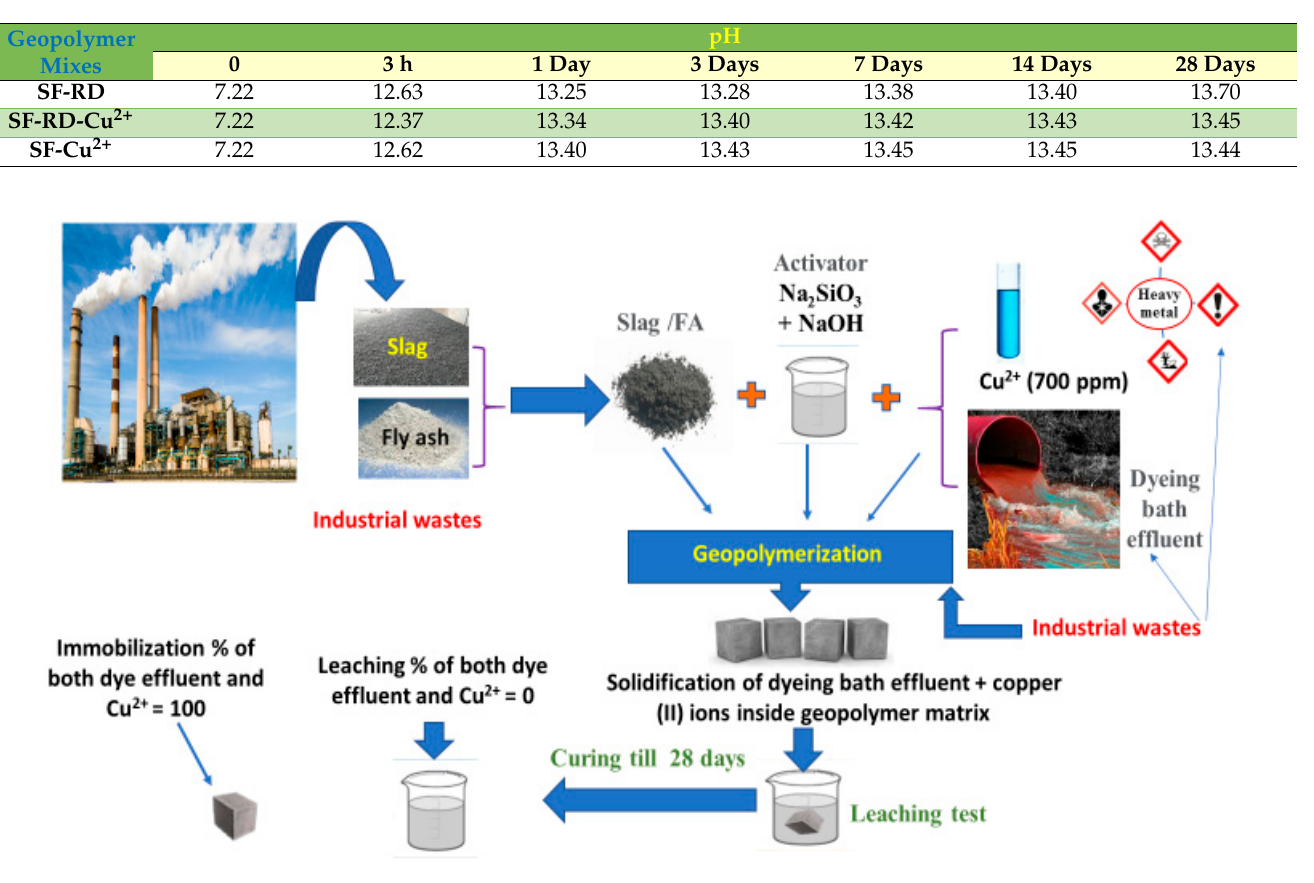
Table 7. Comparison between immobilization and adsorption removal % values for different haz- ardous materials by using slag/fly-ash-based geopolymer (SF).